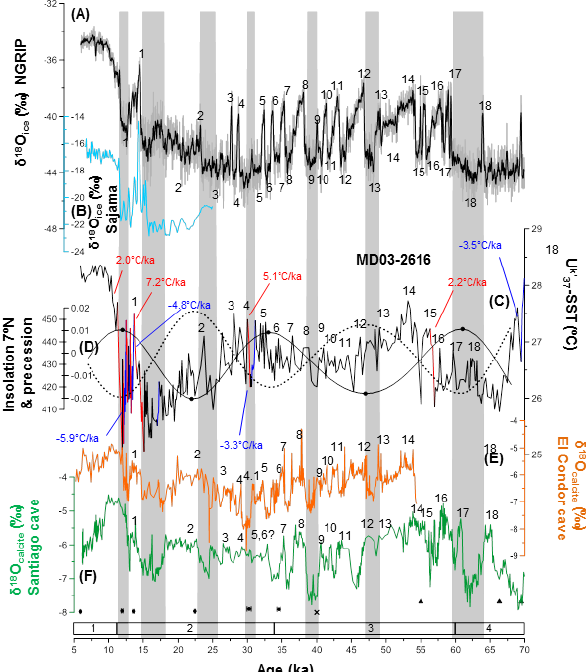
Figure 3. Abrupt changes over MIS4, MIS3 and MIS2. (a) δ 18 O ice (‰) measured in NGRIP (NGRIP, 2004; Wolff et al., 2010), (b) Sajama ice core (Thompson et al., 1998). (c) MD03-2616 (cid:48) U k -SST (this study). (d) Precession (dashed line) and daily in- 37 solation (solid line) at 7 ◦ N during the summer solstice (Berger, 1978). (e) δ 18 O Caclcite El Condor Cave (Cheng et al., 2013). (f) δ 18 O Caclcite Santiago Cave (Mosblech et al., 2012). The abrupt changes identified in the MD03-2616 SST record are operationally defined as a transition faster than 2 ◦ Cka − 1 and with absolute inten- sity equal to or higher than 0.5 ◦ C (Table 3). The blue and red lines represent abrupt cooling and warming SST changes,